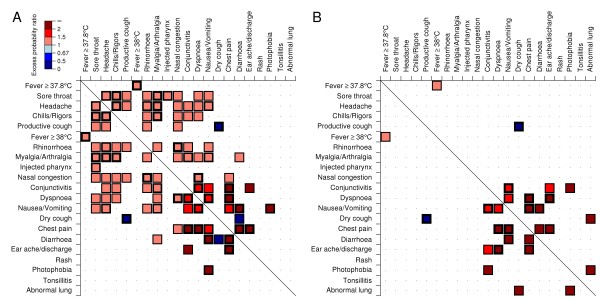
Symptom or sign complexes for A) H1N1-2009, B) Influenza B. Symptoms or signs are ranked by average frequency over the study period over all strains. The expected proportion of symptom pairs assuming symptoms develop independently is the product of the two marginal distributions. The discrepancy between this and the observed proportion of symptom pairs is assessed via a binomial test, with differences that are significant at the 5% level represented by coloured cells, with the thickness of the cell wall indicating the p-value (thin means 1% <p < 5%; medium, 0.1% <p < 1%; and thick, p < 0.1%). Colours encode the excess probability ratio, a measure of effect size, with blue indicating a lower proportion and red a higher proportion observed than expected, and shade indicating the ratio of the empirical proportion that the pair of symptoms appear together relative to what would be expected if their occurrence were independent. With 420 tests, the conservative expected number of false discoveries is 21, assuming all symptoms or signs occur independently".